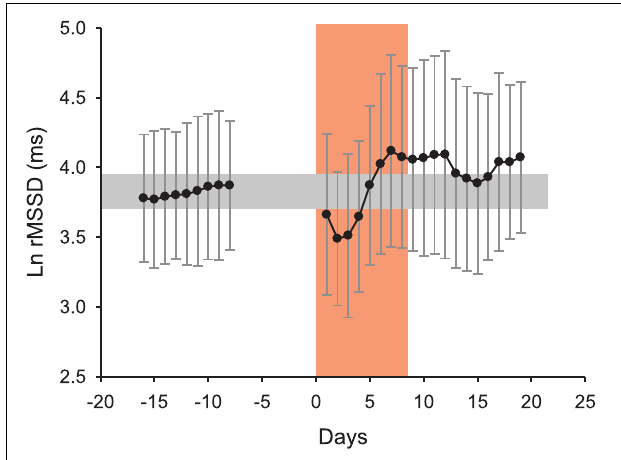
FIGURE 4 | Average changes (90% confidence intervals) in the logarithm of the square root of the mean of the sum of the squares of differences between adjacent normal R–R intervals (Ln rMSSD) measured at rest after awakening in 6 runners (4M-2F, 38.2 ± 1.8 years, 170.7 ± 7.9cm, 65.0 ± 11.6kg, 6.8 ± 2.1h of training per week) before, during and following the 20th “Marathon des sables” (2005, 253km